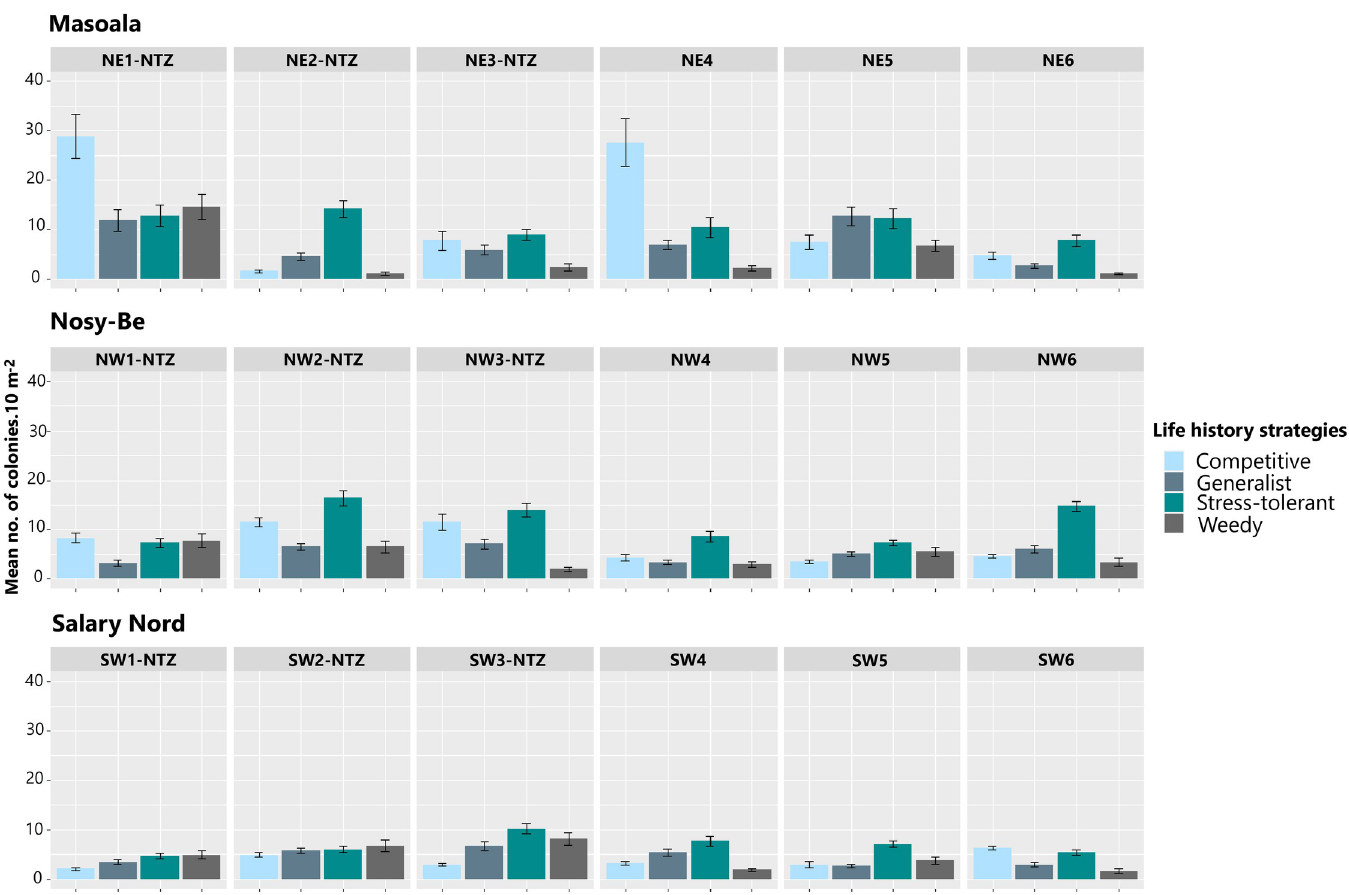
Fig 6. Spatial variation in the abundance of the four coral life history strategies. Data are given for the 18 sampling stations located at the three regions. Errors bars represent standard error.